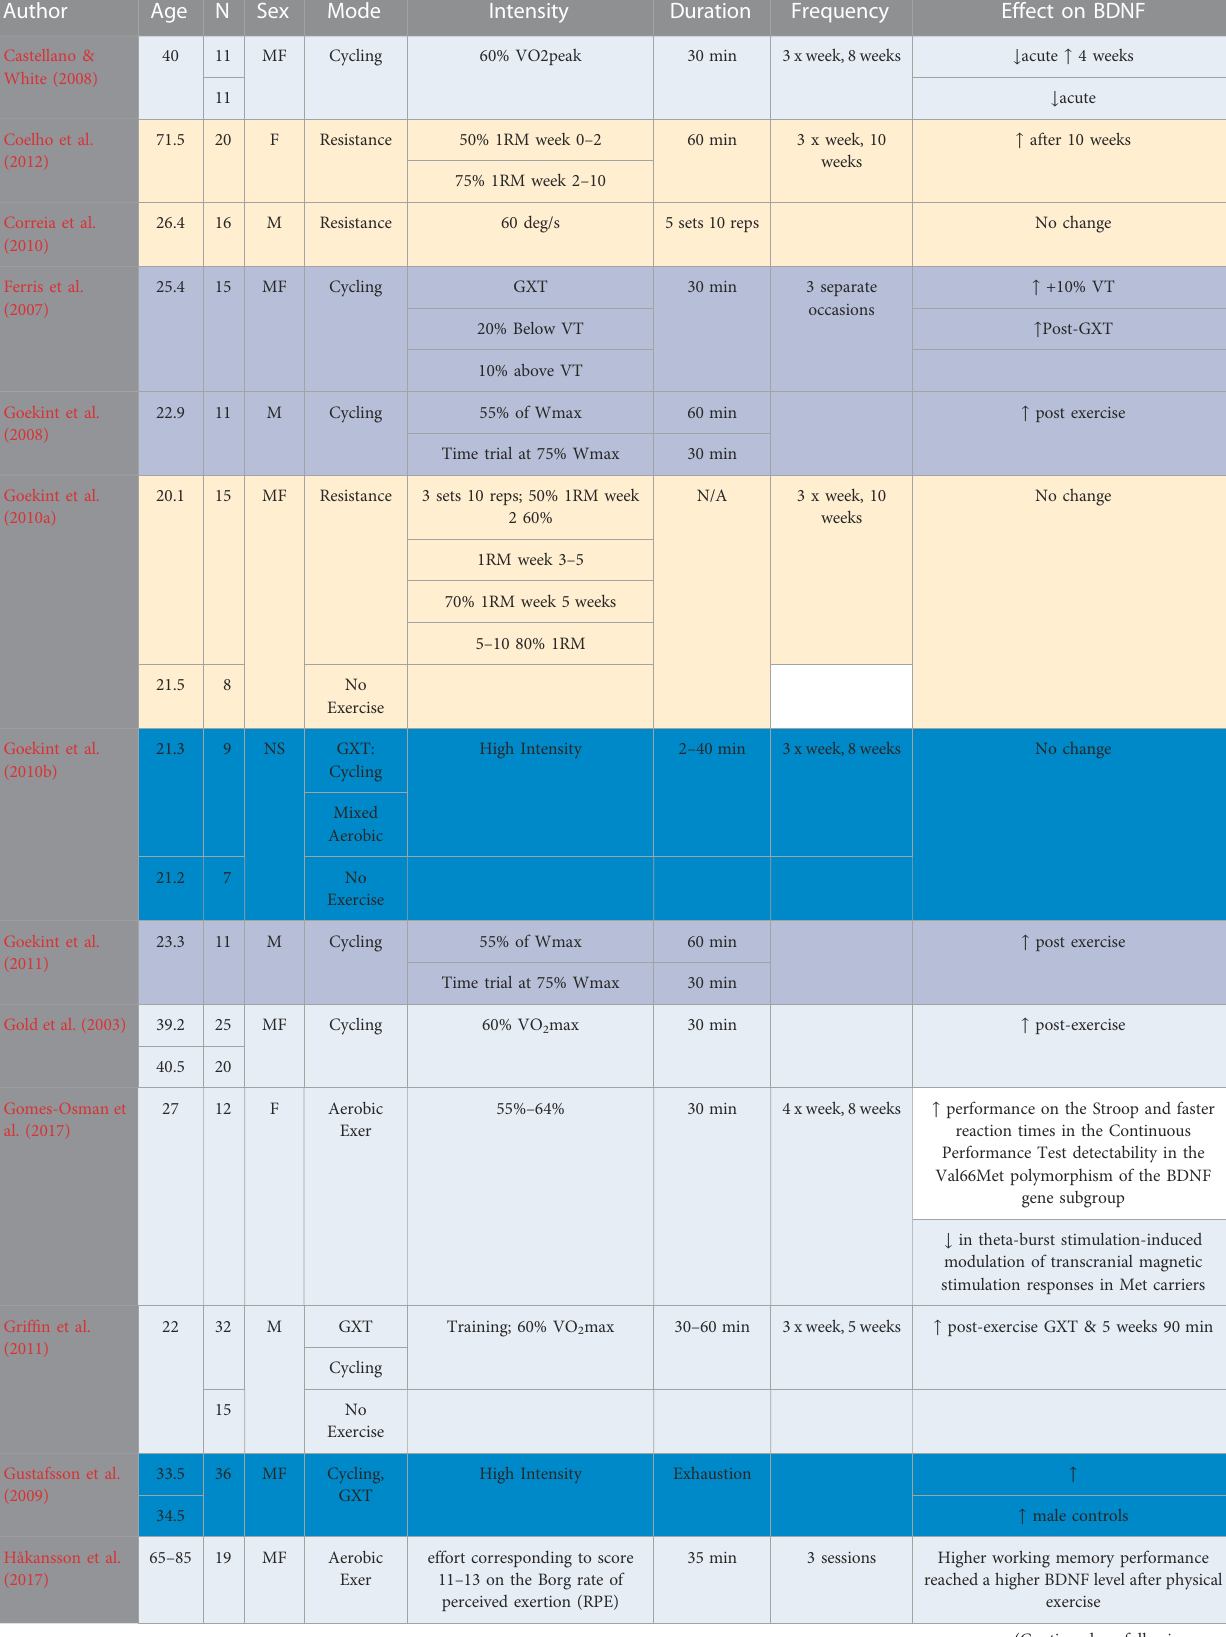
TABLE 2 Effect of exercise and other performance factors on